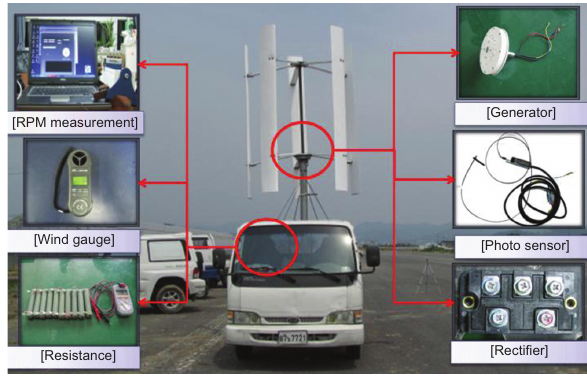
Figure 19 Comparison between test results and estimation results of electrical power produced by prototype small